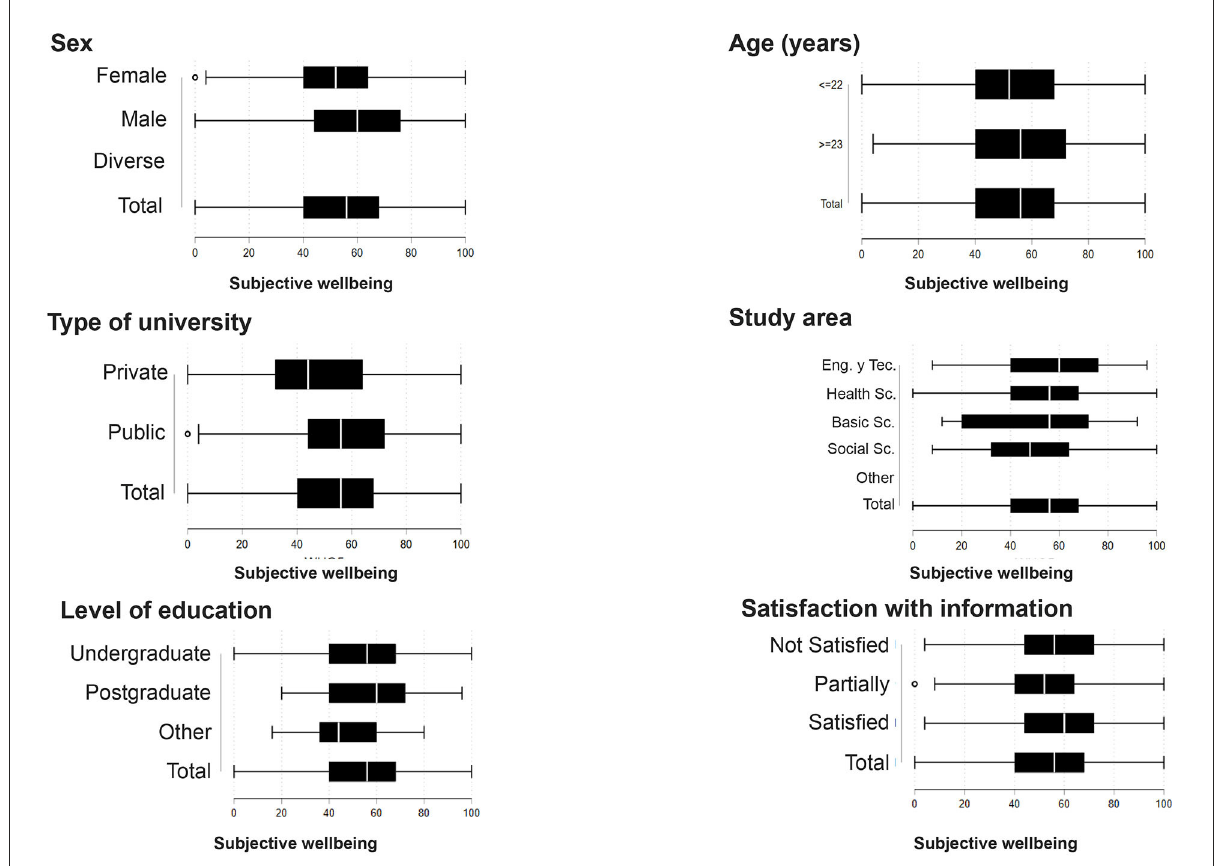
FIGURE2 Box plots between the subjective wellbeing scale and characteristics of the university students. Ecuador,